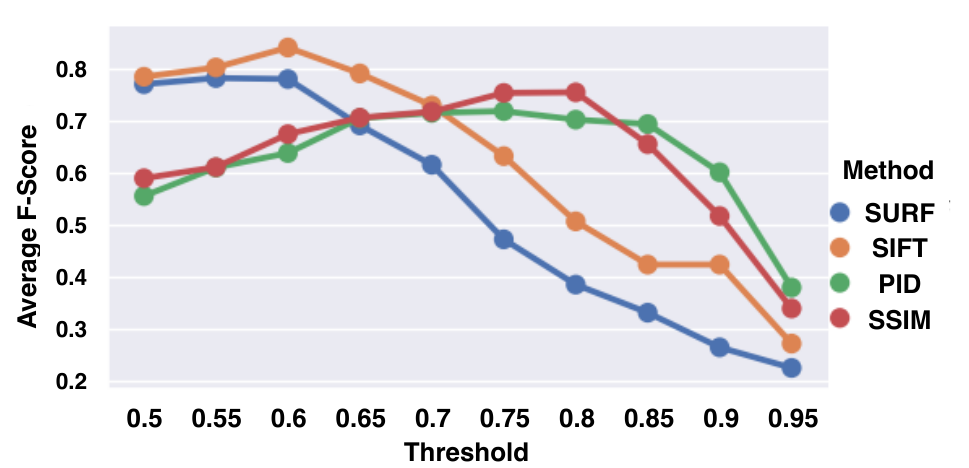
Figure 3. The accuracy of removing duplicate GUI screens using four different methods (feature-wise and pixel-wise) with different similarity thresholds.